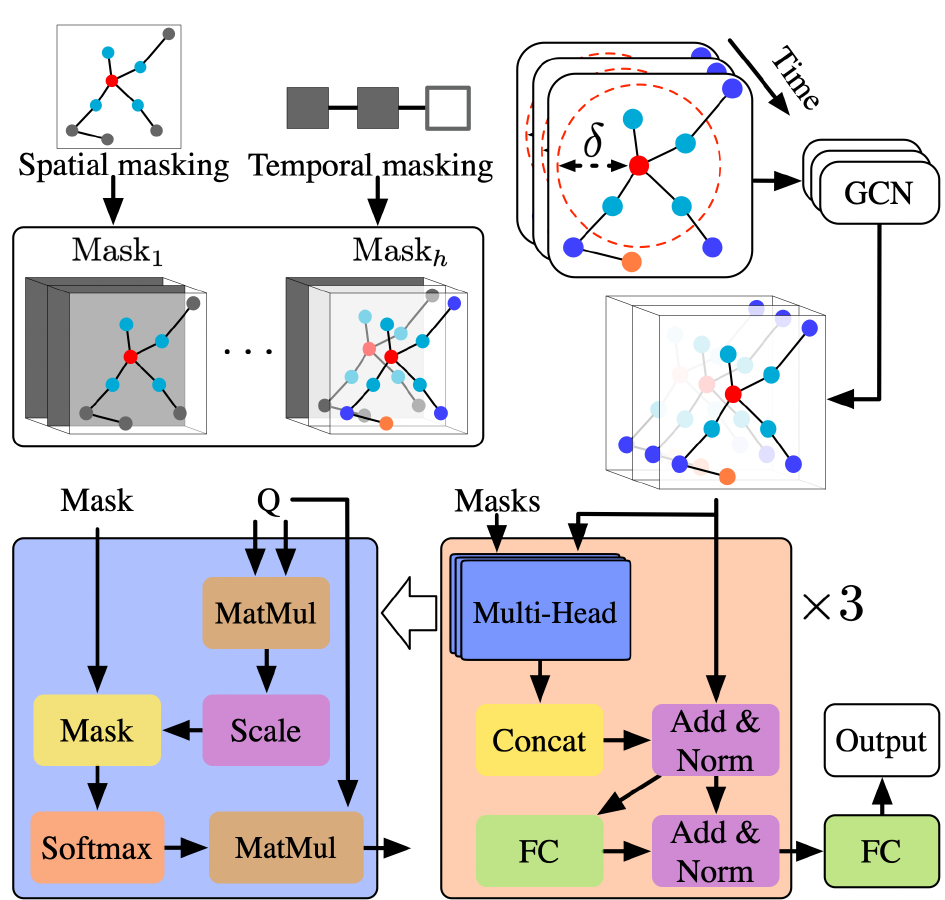
Figure 2. The framework of the proposed